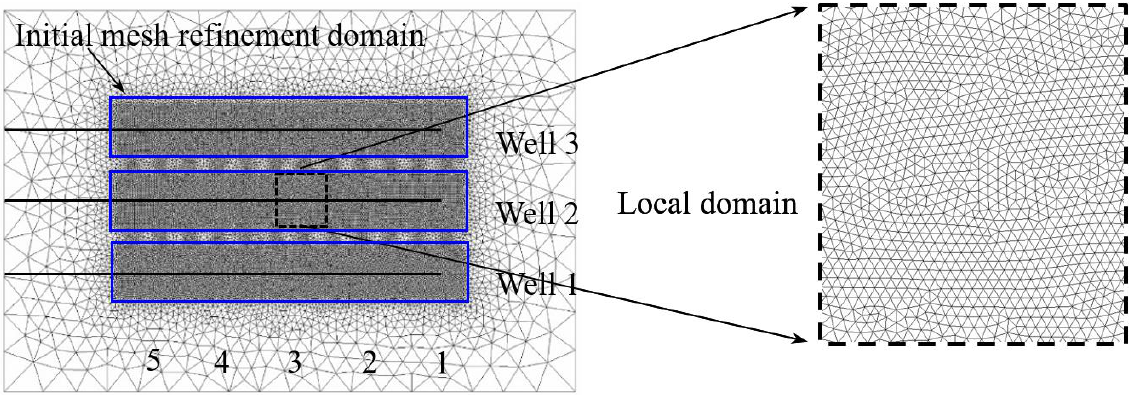
Figure 5. Initial mesh refinement of the finite element model. Table 1. Numerical cases of different well spacings.